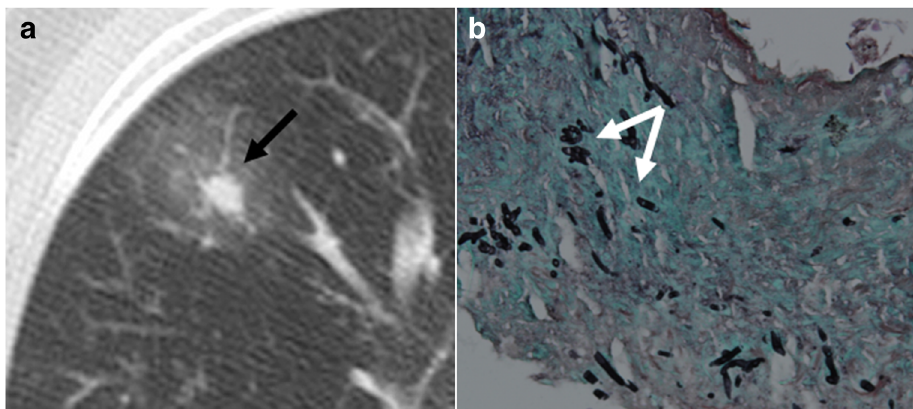
Fig. 17 Angioinvasive Aspergillus fumigatus . General alteration and productive cough. Solid nodule with peripheral ground-glass opacities termed as the B halo sign ^ ( arrow ) ( a ). Pathology showed branching filaments ( arrows ), consistent with angioinvasive aspergillosis ( b )